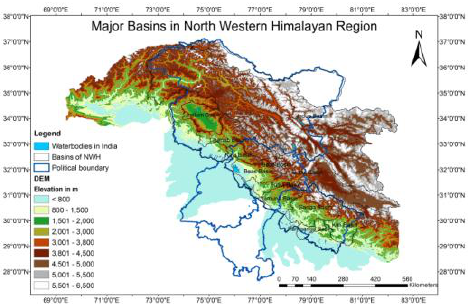
Figure 1: Topographical map of NWH and the major basins